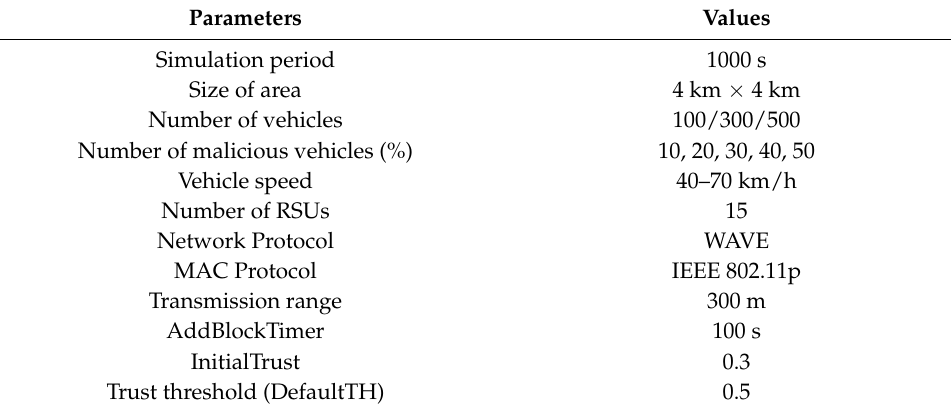
Figure 5. Network Map. Table 1. Simulation Details.